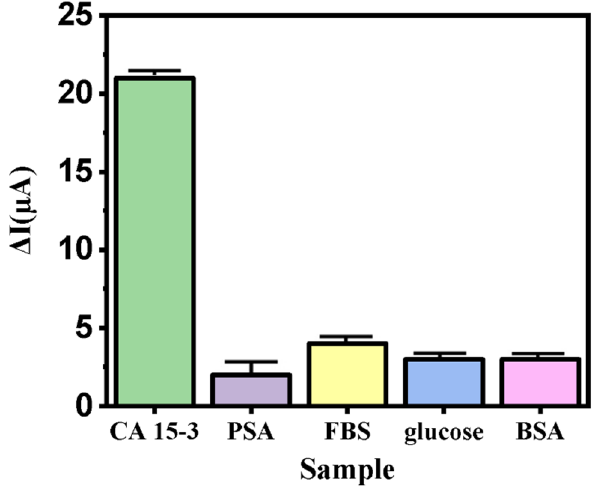
Figure 8. Comparison of nanoprobe electrode signal for CA 15-3 (5 U mL − 1 ) glucose (90 mg dL − 1 ),